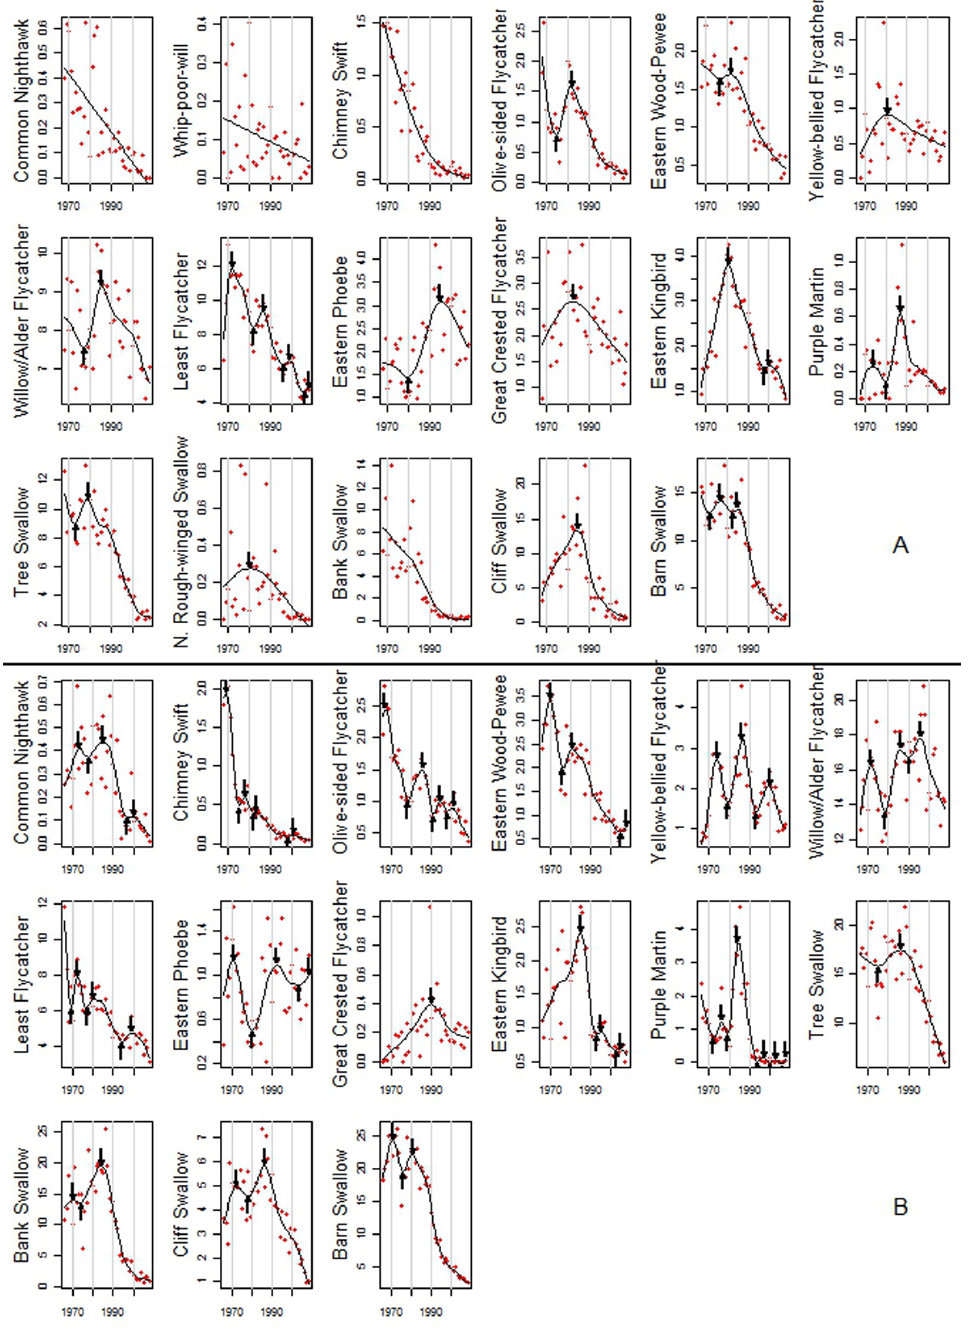
Fig. 3 . Population trends in two eastern Canadian bird conservation regions: A) Boreal Hardwood Transition, and B) Atlantic Northern Forest. The red points are the Breeding Bird Survey annual abundance indices; the black line is the fitted value of a generalized additive model (see text). Arrows indicate a change in slope. All aerial insectivores in the two regions are shown. After 1980, virtually all population trends are